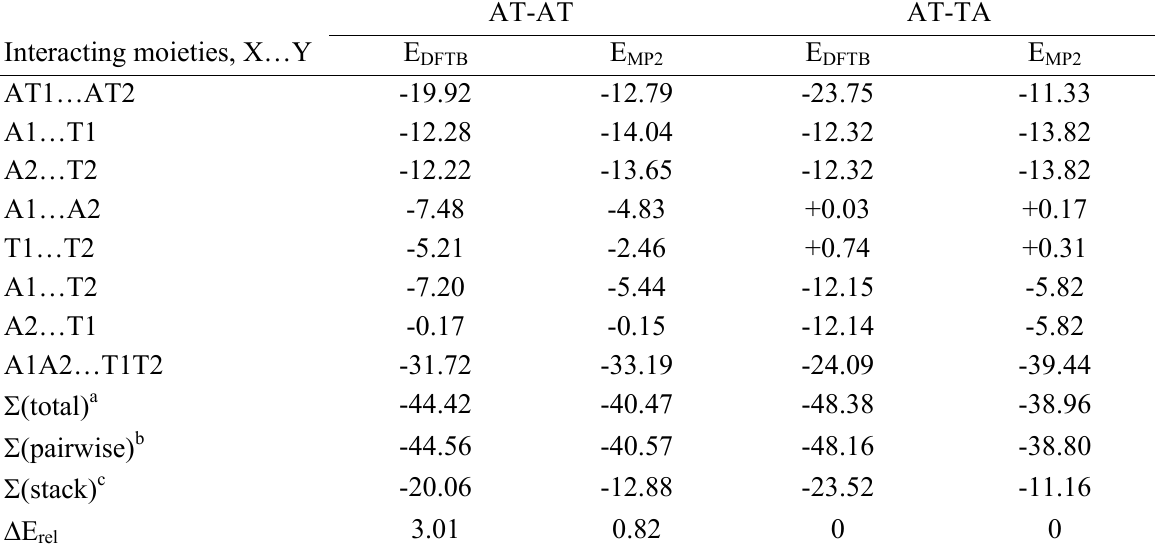
Table 3. Energy (kcal/mol) of intermolecular interactions between different moieties of stacked dimers and relative energies of dimers ( ∆ E rel